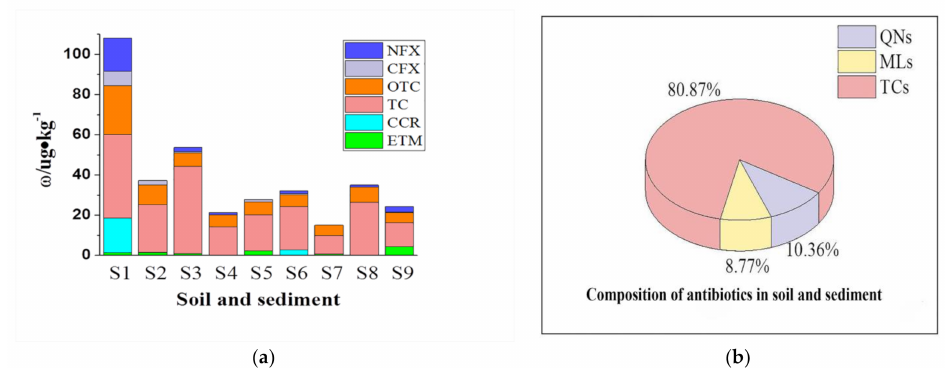
Figure 3. ( a ): Distribution of antibiotics in soil/sediment in Anqing; ( b ): composition of antibiotics soil/sediment samples.